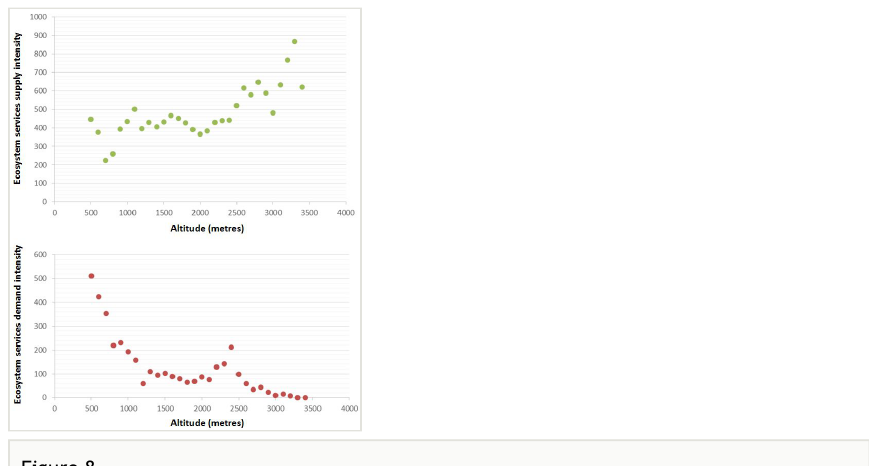
Scatter plots showing the relationship between altitude and the supply and demand of ES in the study